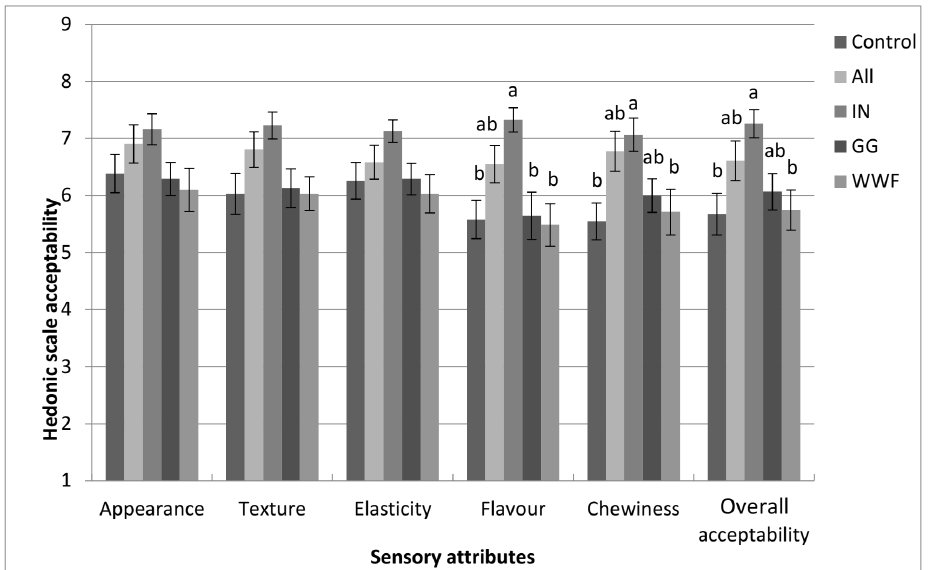
Figure 8. Acceptability of sensory characteristics of Pita breads, from 1 (strongly dislike) to 9 strongly like, ( n = 31, mean scores ± S.E.M). The a and b letters within formulation treatments indicate statistically significant differences ( p < 0.05).